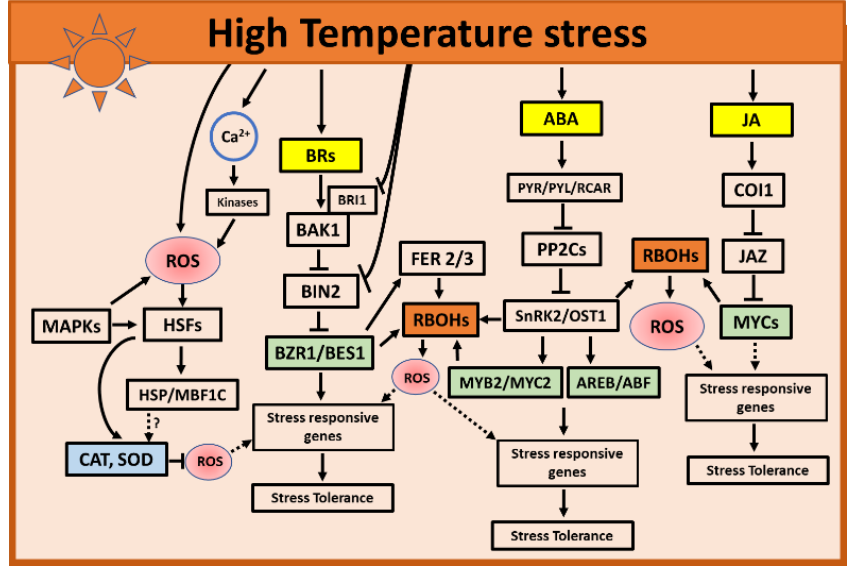
Figure 2. Selected hormone and ROS interactions in response to high-temperature stress. During high temperatures, ABA-regulated kinases such as SnRK2 or TFs activate RBOHs to generate ROS. Similarly, in the BR-signaling pathway TF BZR1 activates RBOHs to generate ROS. Along with TFs, the generated ROS may activate and induce the expression of stress-responsive genes to orchestrate the appropriate molecular and physiological acclimation responses to high temperatures. Other plant hormones such as ET, SA, and CKs may also play roles in inducing stress responses to high temperatures. Only ABA, BRs, and JA were selected to be presented in the mode due to the availability of a relatively large amount of data supporting their roles in ROS interactions in response to high-temperature stress. Solid arrows and blocked arrows indicate confirmed positive and negative regulations. Dashed lines indicate potential interactions. The hormones are indicated in yellow, transcription factors in green, ROS in red, and ROS-producing and -scavenging enzymes are indicated in brown and blue, respectively. ABA, abscisic acid; AREB/ABF, ABA-responsive element-binding protein/ABA-binding factor; BR, brassinosteroid; BAK1, BRI1-ASSOCIATED KINASE1; BES1, BRI1-EMS SUPPRESSOR1; BIN2, brassinosteroid insensitive 2; BRI1, BRASSINOSTEROID INSENSITIVE1; BZR1, BRASSINAZOLE-RESISTANT1; Ca 2+ , calcium; CAT, catalase; COI1, CORONATINE-INSENSITIVE 1; FER, FERONIA; HSF, HEAT SHOCK FACTOR; HSP, heat shock proteins; JA, Jasmonic acid; JAZ, JASMONATE-ZIM-DOMAIN; MAPK, mitogen-activated protein kinase; MBF1C, MULTIPROTEIN BRIDGING FACTOR 1C; MYB/C, MYB/C transcription factors; OST1, OPEN STOMATA 1; PP2C, protein phosphatase 2Cs; PYR/PYL/RCAR, pyrabactin resistance protein or PYR-like proteins; RBOHs, respiratory burst oxidase homologs; ROS, reactive oxygen species; SnRK2, SNF1-related protein kinase 2; and SOD, superoxide dismutase. 3.2.2. Role of BRs during High Temperatures The perception of BR by its receptor BRASSINOSTEROID INSENSITIVE1 (BRI1) fa- cilitates the interaction of the active BR1 with a coreceptor BRI1-ASSOCIATED KINASE1 (BAK1). This interaction positively regulates the BR-signaling components BRASSI- NAZOLE-RESISTANT1 (BZR1) and BRI1-EMS SUPPRESSOR1 (BES1) to enhance the ex- pression of heat-responsive genes (Figure 2) [108]. For example, at high temperatures, the accumulation of BES1 and BZR1 increases, and BZR1 binds to the E-box and G-box ele- ments of the PHYTOCHROME INTERACTING FACTOR 4 ( PIF4 ) promotor to regulate its expression. This interaction induces the expression of growth-promoting genes, thus reg- ulating the thermomorphogenesis [109]. Additionally, thermomorphogenic genes are ac- tivated by the abundant levels of the BES1-PIF4 complexes, highlighting the roles of BR- induced TFs in attaining thermotolerance [110,111]. A recent study in Arabidopsis also indicated that a loss-of-function of BRI1-EMS-SUPPRESSOR 1 ( bes1 )-mediated BR signal- ing, exhibited the most sensitive characteristics to heat stress, such as a lower PSII photo- chemistry efficiency ( Fv/Fm ), higher lipid hydroperoxide contents, higher photoinhibi- tion, and photo-oxidative stress compared to the wild type [112]. In barley ( Hordeum vul- gare ), the mutants deficient in BR biosynthesis and signaling negatively affected the accu- mulation of the HSP transcripts and heat-shock proteins, demonstrating the role of BRs in attaining plant acclimation to high temperatures [113,114]. In addition, BRs were shown